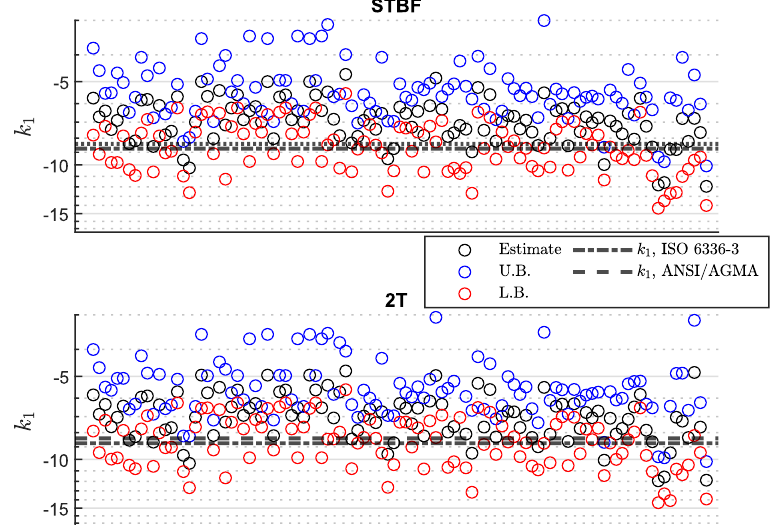
Figure 15. Comparison of estimated k 1 (and its confidence interval) with its standardized equivalent.